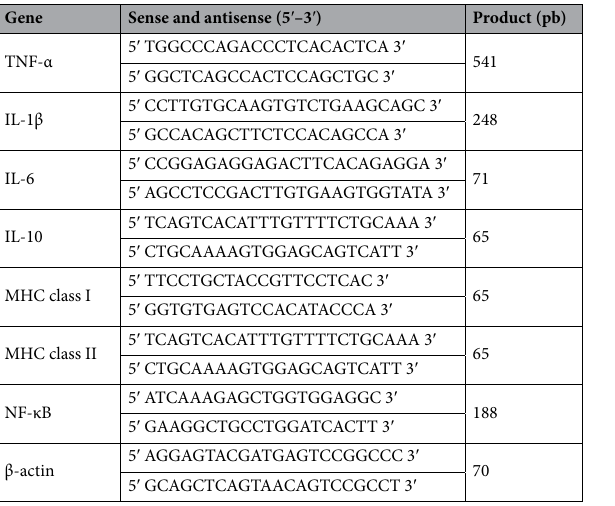
Table 1. Primer sequences used for Real Time PCR